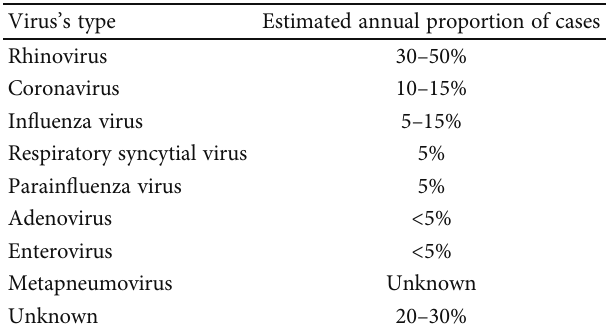
Table 2: Estimated annual proportion of clinical case based on virus ’